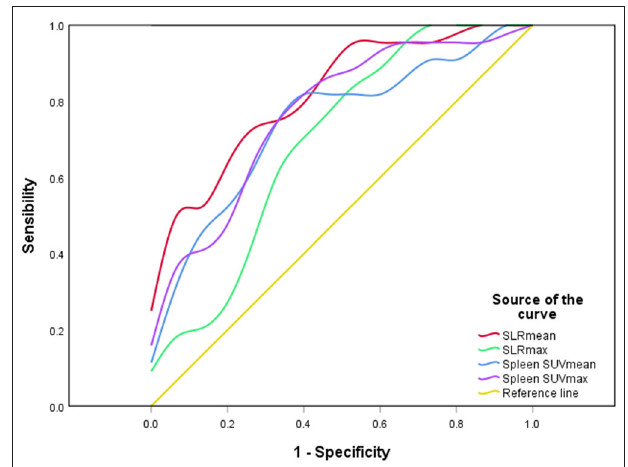
FIGURE 6 | A ROC curve of spleen metabolic parameters. SLRmean had the highest ROC value ( P < 0.001).